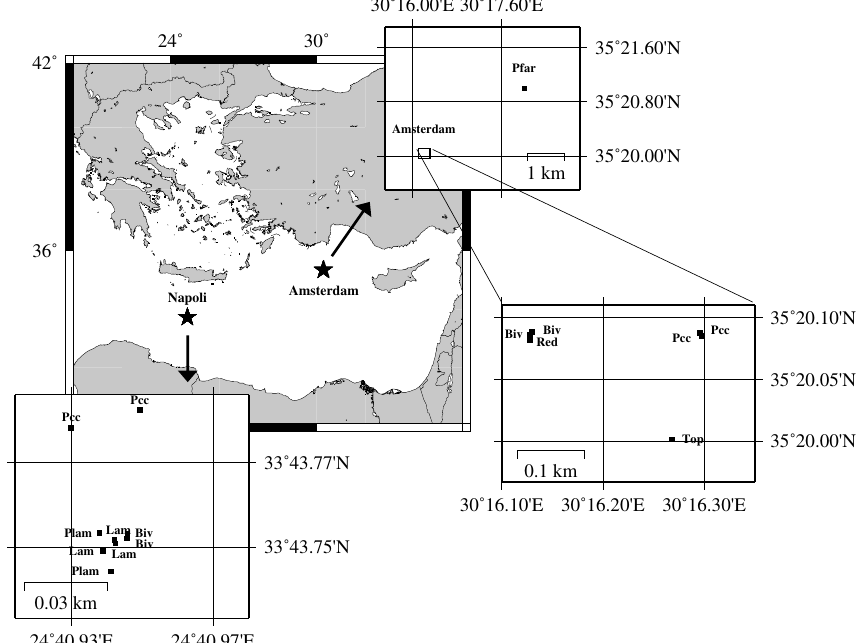
Fig. 1. General map of the eastern Mediterranean Sea with the location (black stars) of the two mud volcanoes, Amsterdam and Napoli. Zoom-view maps show detailed positions of the different microhabitats: (Biv: bivalve shells; Pcc: periphery of carbonate crusts; Red: reduced sediments; Top: summit of the mud volcano; Lam: Lamellibrachia microhabitat; Plam: periphery of Lamellibrachia ; Pfar: far